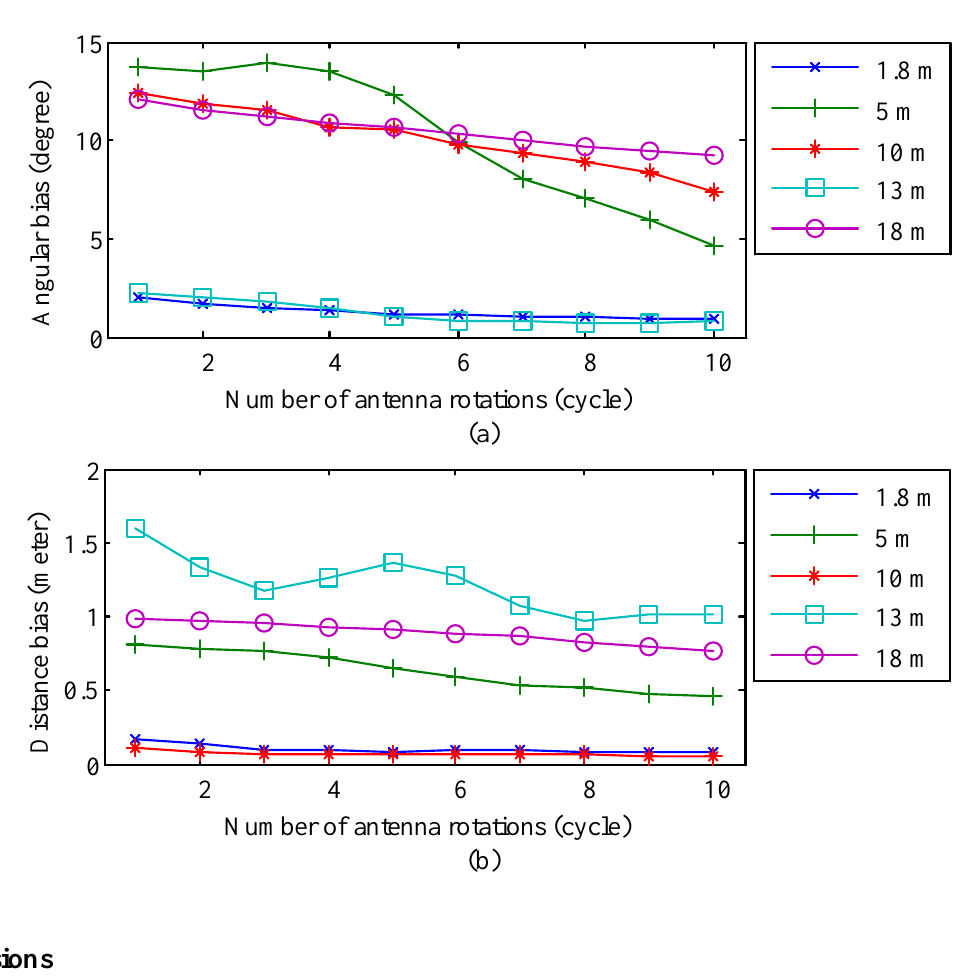
Figure 16. (a) Average angular biases and (b) averaged distance errors yielded by the proposed algorithm versus different number of antenna rotations